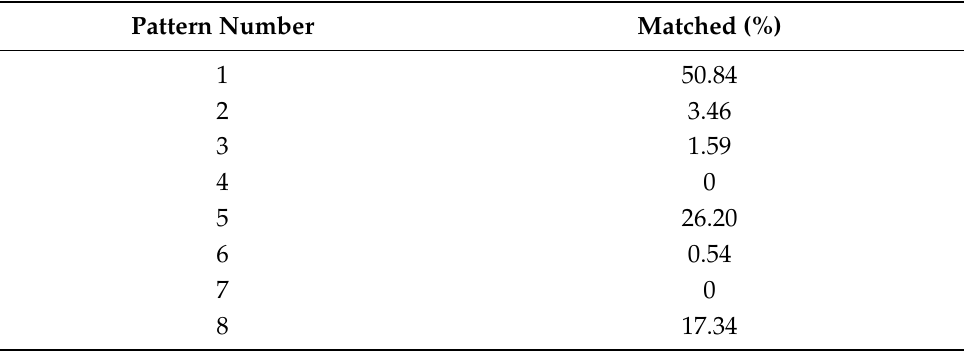
Table 3. Appearance probability of hand patterns.